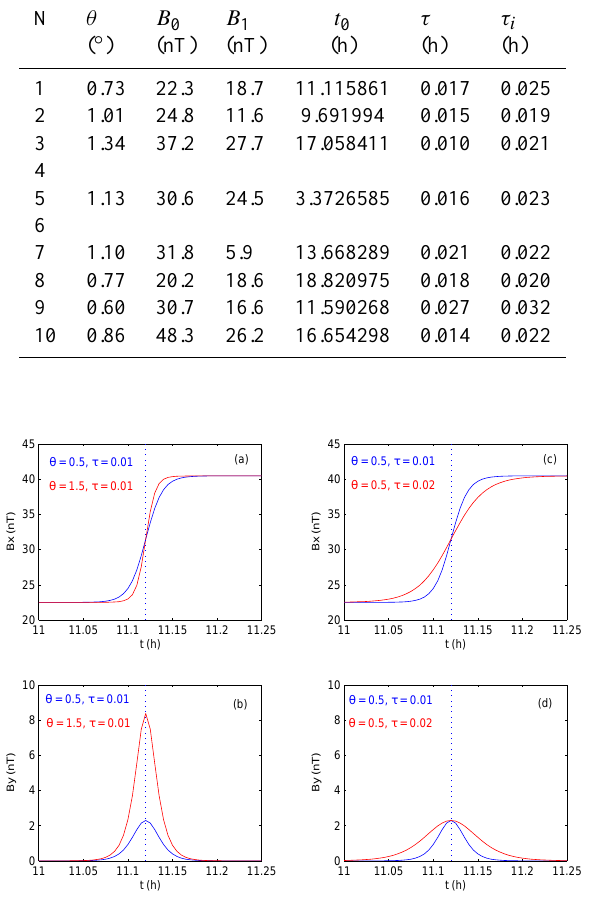
Fig. 13. Changes in B x and B y components according to the Collier et al. (1998) model for different values of τ and θ . The dashed line shows the midpoint time t 0